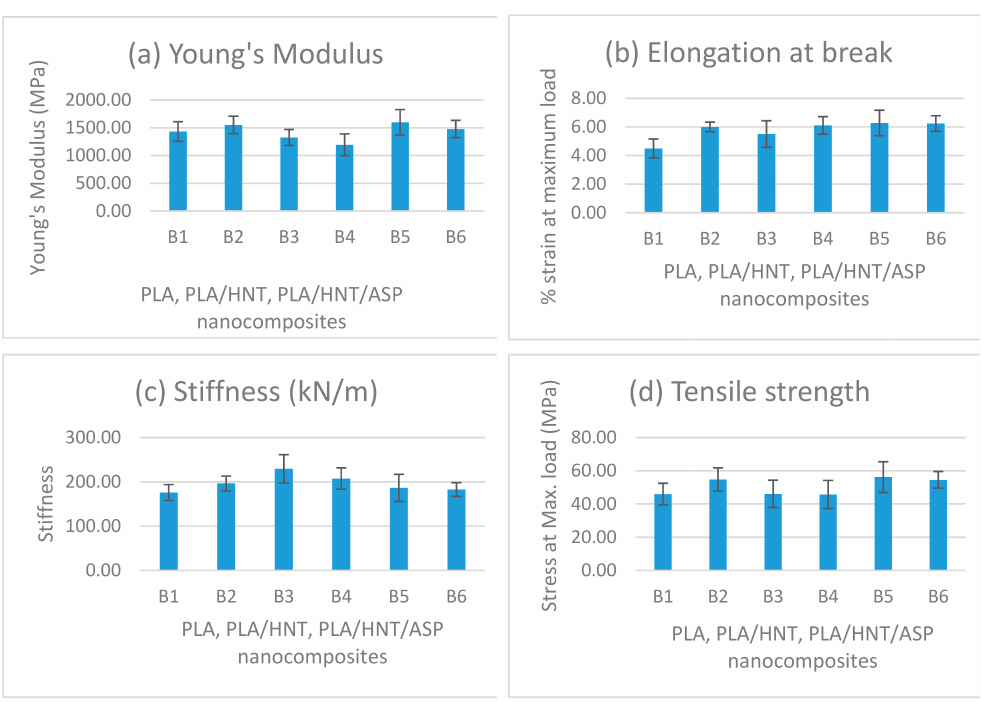
Figure 6. Mechanical properties of the nanocomposites are shown in the above graph. ( a ) Young’s modulus of the preloaded 2:1 nanocomposite (B5) is significantly higher with p- value of 0.001. ( b ) Elongation at break does not show any significant change. ( c ) Sti ff ness significantly increases for 2:1 matrix-loaded nanocomposite (B3) with a p- value of 0.001. ( d ) Tensile strength significantly increases for preloaded 2:1 nanocomposite (B5) batch with p -value of